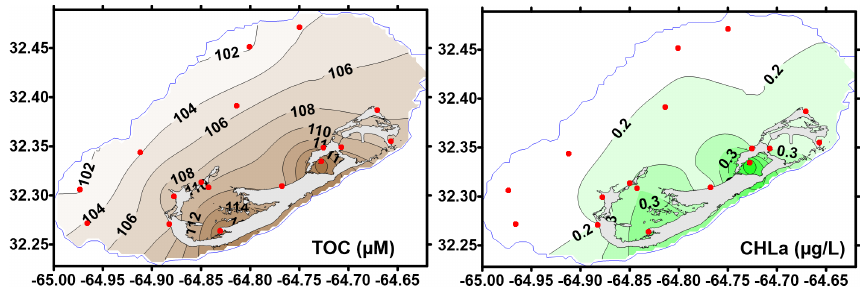
Figure 2. Isopleths of period-of-record averages for total organic carbon (TOC; µM) and chlorophyll a (Chl a ; µgL − 1 ) in the water column on the Bermuda Platform. The blue lines are the 20m isobaths on the rim of the platform. Red dots indicate locations of the 17 permanent sampling locations.